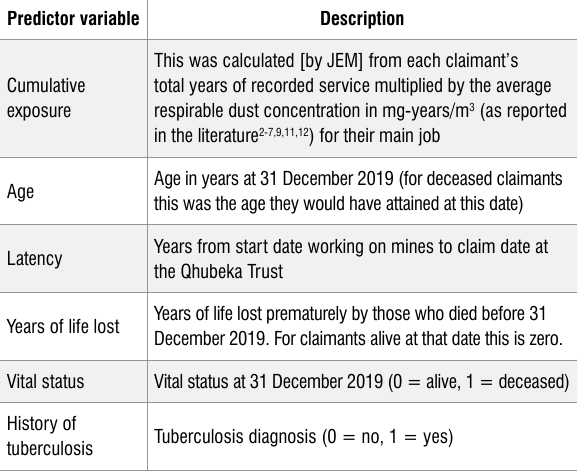
Definitions of classification accuracy